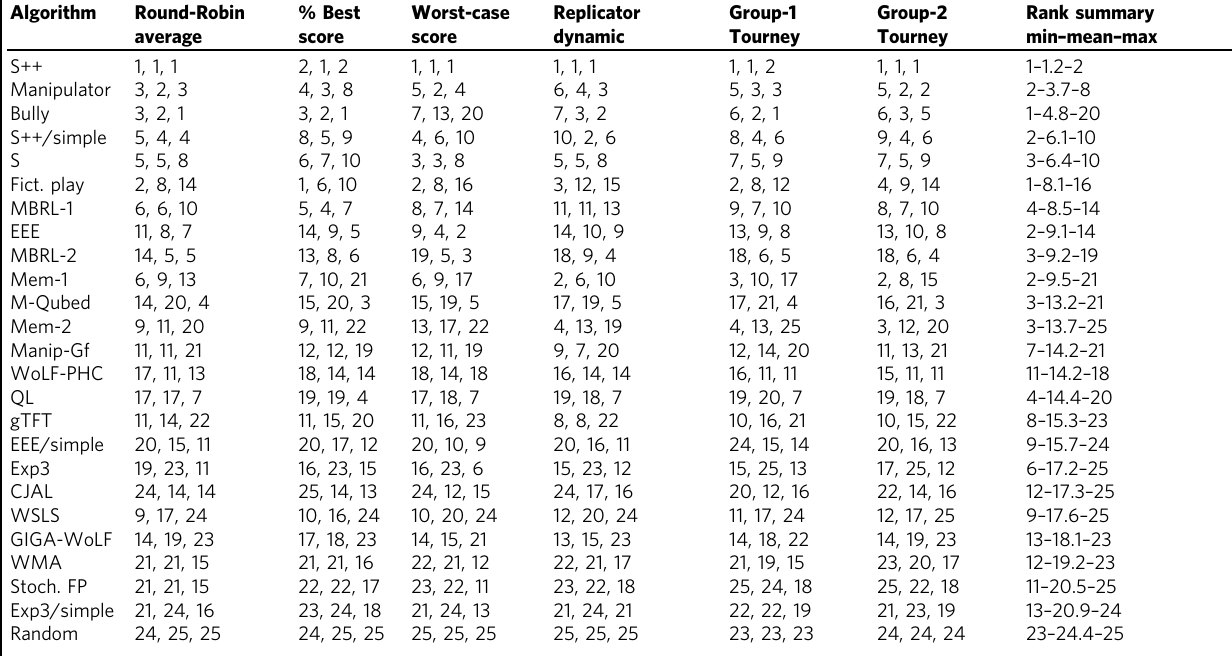
Table 1 Summary results for our comparison of algorithms Algorithm Round-Robin